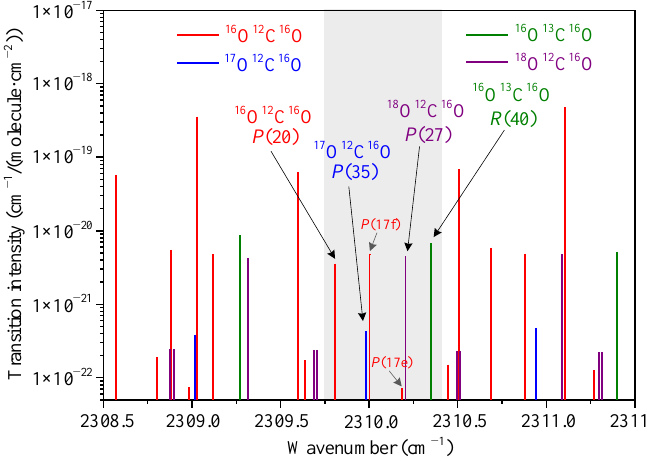
Figure 1. Absorption lines of CO 2 isotopes at 4.33 µ m based on HITRAN